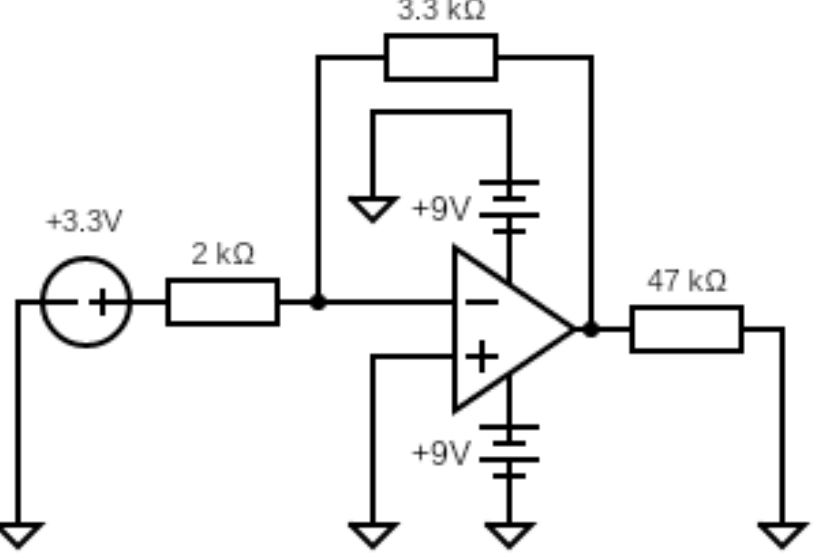
Figure 2. Test circuit schematic for an inverting amplifier with a nominal 3.3 V input signal and supplied with nominal 9 V ba tt eries.